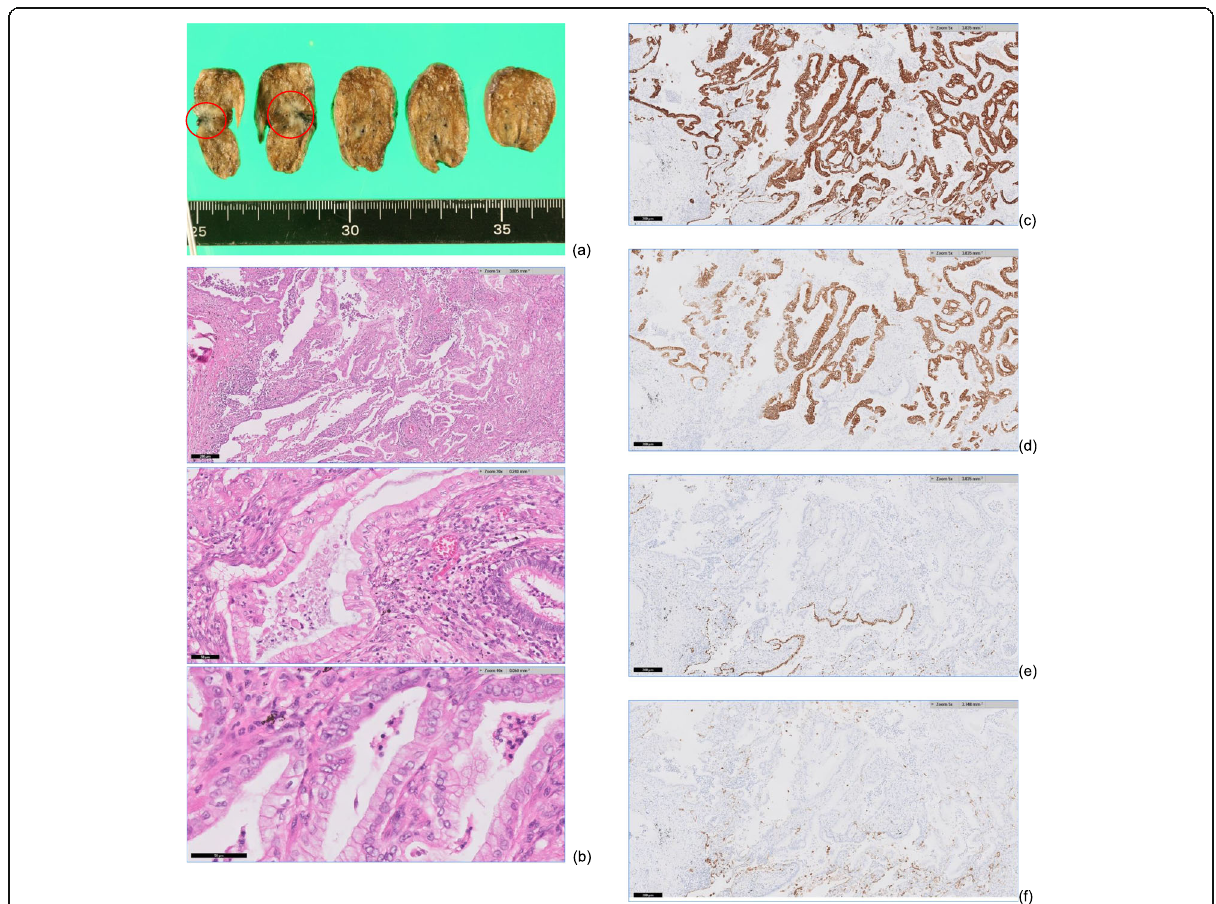
Fig. 2 Histopathological and immunostaining findings with a the tumor location indicated by the circle and b hematoxylin-eosin staining of tissue with columnar tumor cells, nuclear atypia, and mucus containing mucus vesicles. Immunostaining shows c , d diffuse expression of cytokeratin 7 and 20 and e , f negative staining of thyroid transcription factor 1 and Napsin